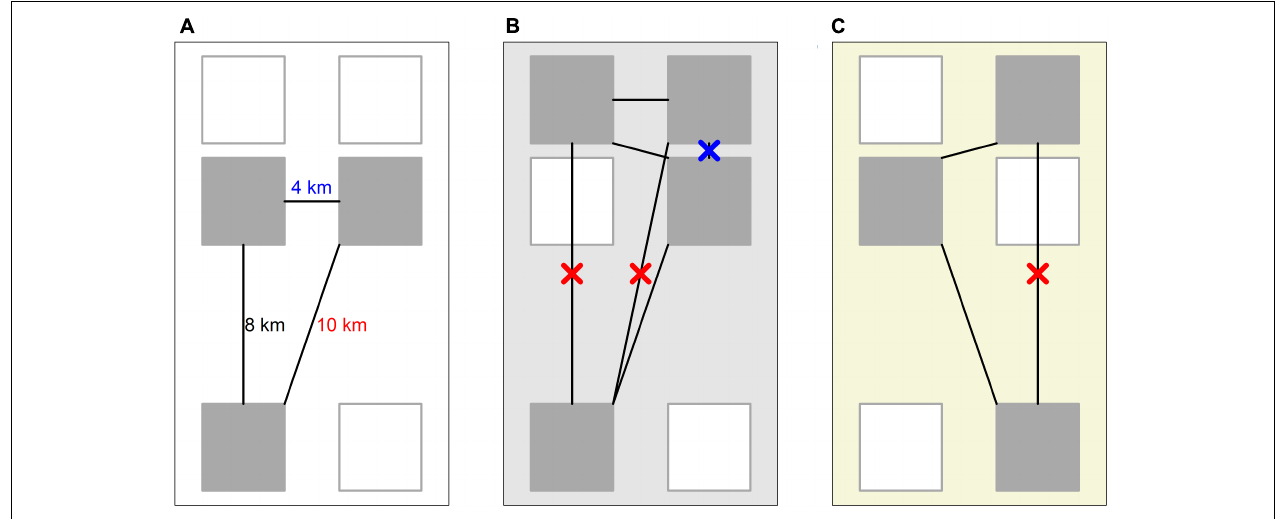
FIGURE 2 | An illustration of Geographic Spread Subsampling. Each large colored rectangle (white, light gray, and yellow) represents the fossil record of a particular time bin. There are six localities available for sampling (gray rectangles), those unsampled filled white instead of gray. Time bin A is the bin with the lowest geographic spread of sampling. The largest (red) and smallest (blue) geographic distances between the localities define which pairs of localities will be included in beta diversity estimates of subsequent time bins. In B and C , those pairs of localities separated by greater (red crosses) or smaller (blue cross) geographic distances than the bounds defined by time bin A are not